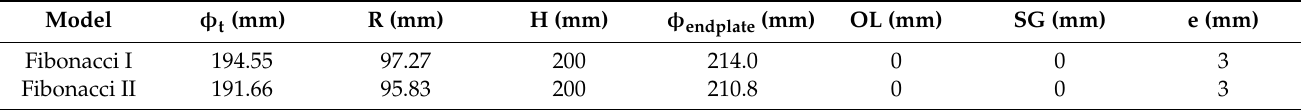
Table 1. Characteristics of the analyzed wind turbines.